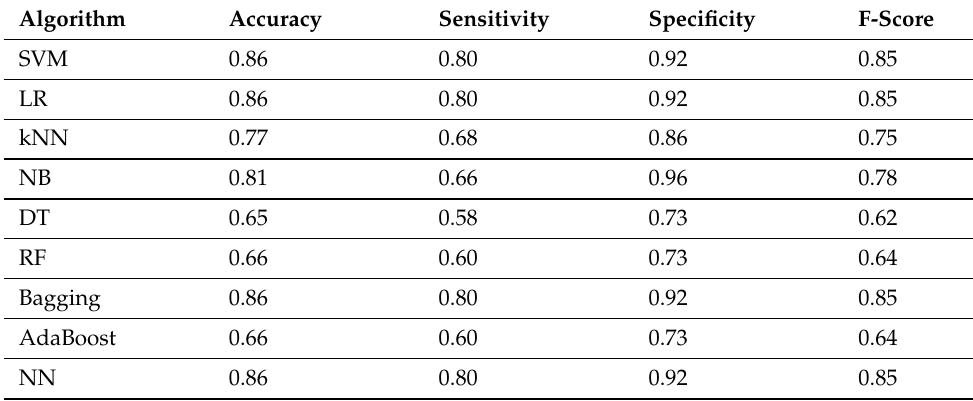
Table 7. Results using C 4 H 8 O